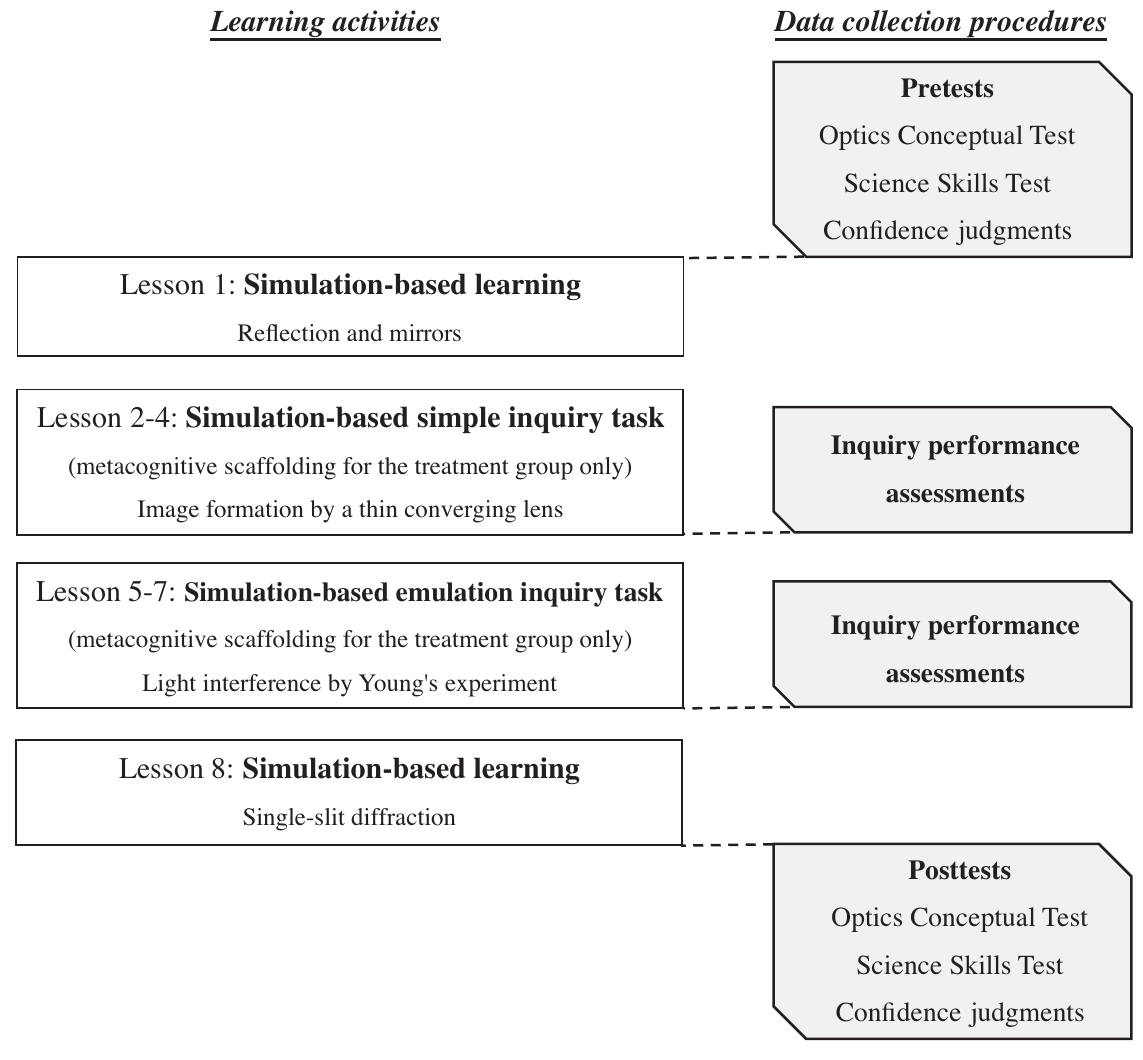
FIG. 1. Learning activities and data-collection